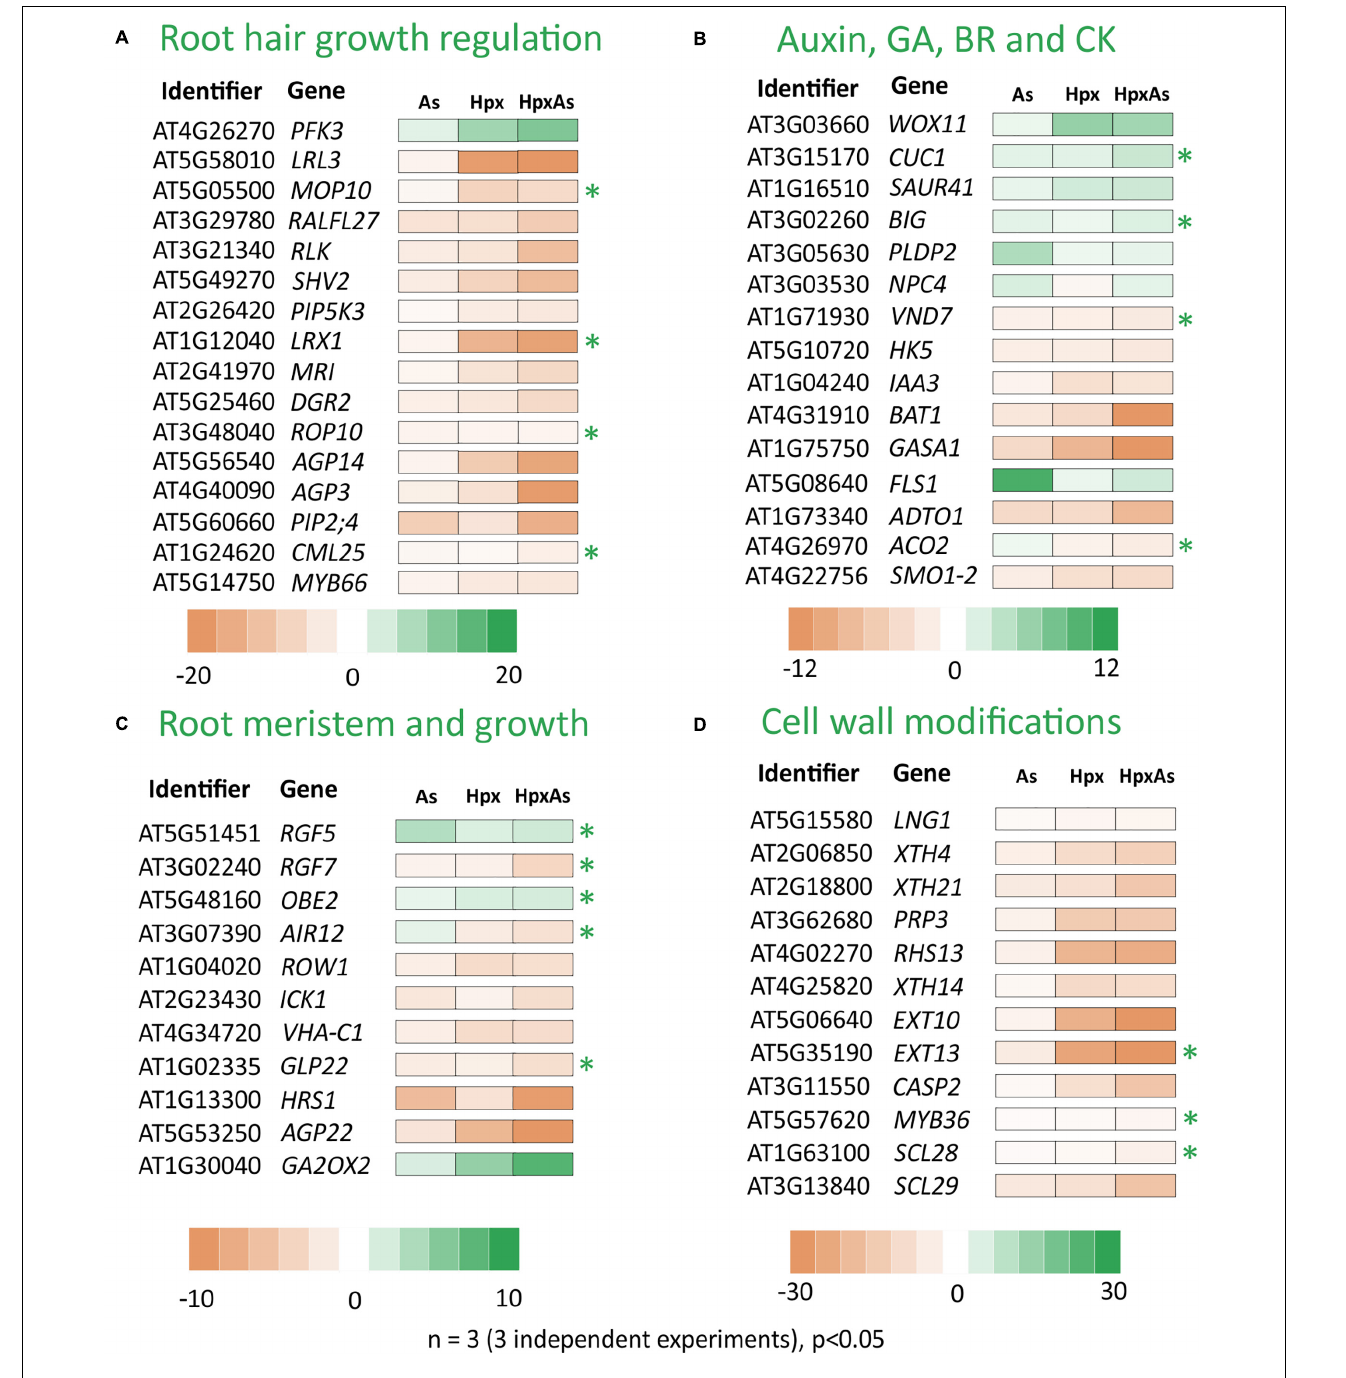
FIGURE 2 | As-, Hpx-, and HpxAs-dependent changes in transcripts linked to root growth and related signaling. Heat maps present root transcriptome data from HpxAs-treatment experiments (GEO-NCBI accession number GSE119327) (Kumar et al., 2019). The transcripts were compared for changed expression under As, Hpx and HpxAs treatment. Four functional categories of genes are presented namely those related to (A) RH growth regulation and epidermal cell differentiation, (B) biosynthesis and signaling of hormones involved directly in different aspects of root development especially linked to auxins, gibberellic acid (GA), brassinosteroids (BR) and cytokinin (CK), (C) control of root meristem activity and total root growth, and (D) cell wall growth or modification crucial in RH or lateral root development. The transcripts were initially selected with the GO term “Root development” using the criterion –2 ≥ fc linear ≥ 2 and later sub-categorized. Among transcripts with a significant response (FDR p ≤ 0.05) to the treatments, heat maps present those with unique response to HpxAs or those with relevance to observed HpxAs-stress effects on root development. Transcripts with unique response to HpxAs (–2 ≥ fc linear ≥ 2 for HpxAs, FDR p ≤ 0.05 and either response below this threshold for As, Hpx or response statistically not-significant) are marked with an asterisk. Supplementary Table 1 gives the complete gene list with relative expression under different treatments.